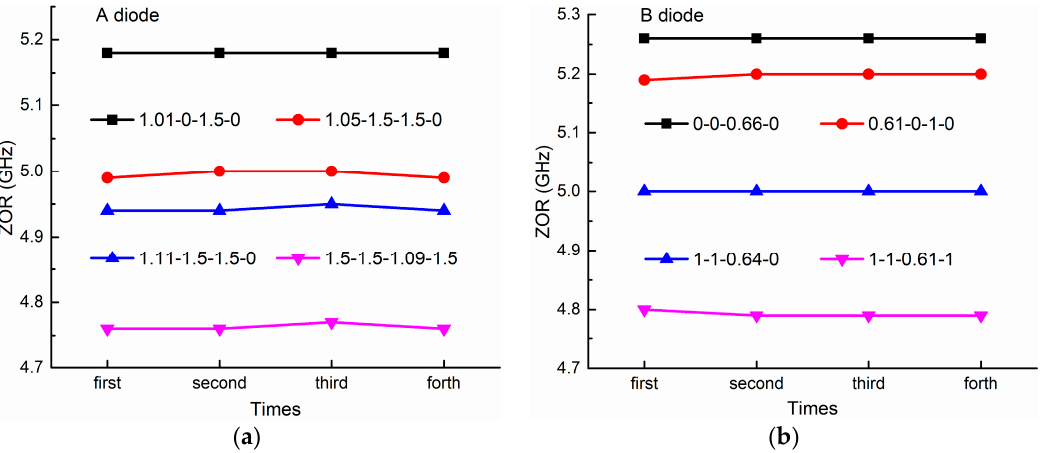
Figure 12. The stability of the nonlinear states with ( a ) PIN diode A and ( b ) PIN diode B.